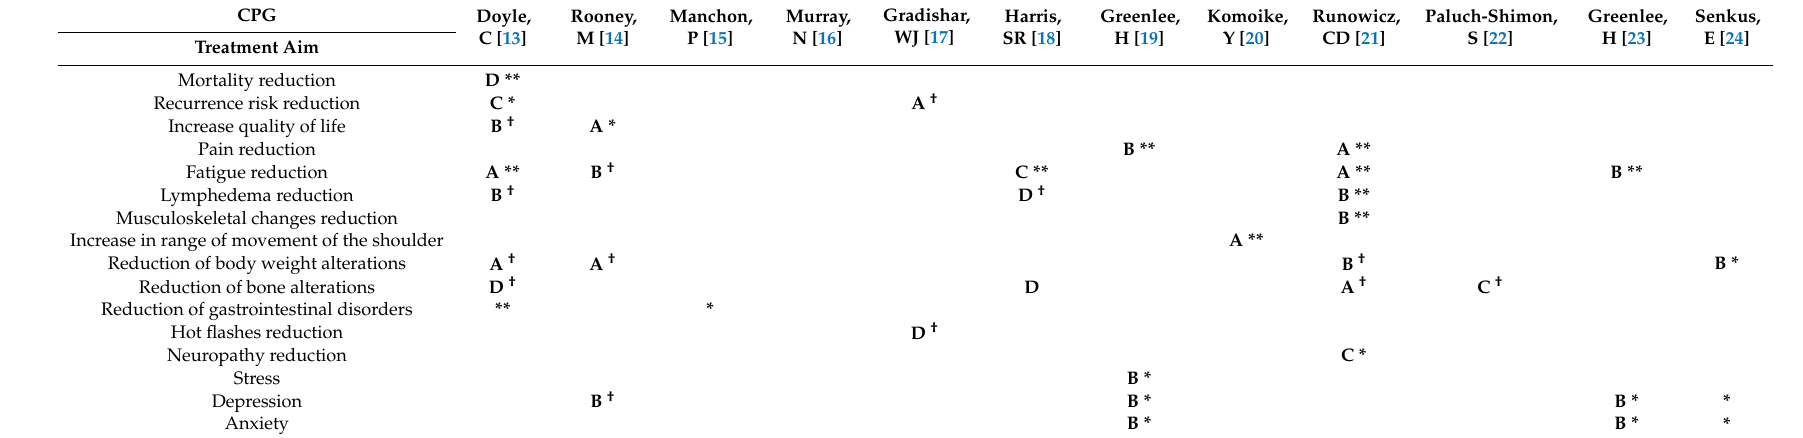
Table 4. Levels of Evidence and degrees of recommendation of the therapeutic physical exercise to reduce the adverse e ff ects of breast cancer treatment, shown in the clinical practice guidelines